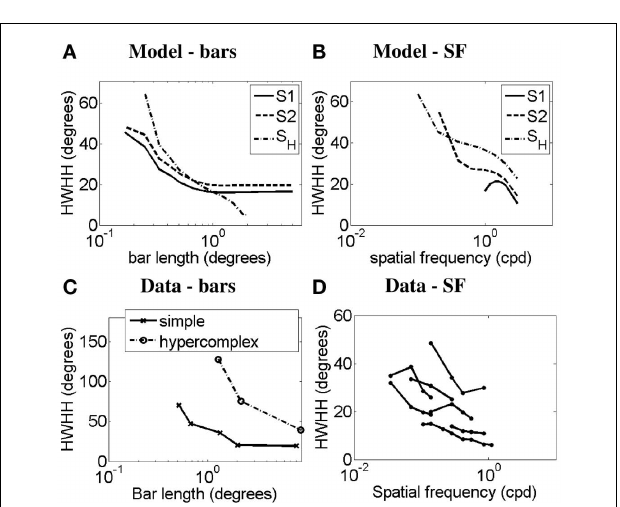
FIGURE 9 | Half-width-at-half-height (HWHH) versus bar length and HWHH versus spatial frequency. HWHH versus bar length curves produced by (A) the model and (C) real simple cells in response to bars (Data adapted from Henry et al., 1974 and Orban et al., 1979). In (A,C) the y -axis represents the HWHH in degrees, and the x -axis represents the bar length in degrees. HWHH versus SF curves produced by (B) the model in response to gratings and Gabor patches and (D) real simple cells in response to gratings (Data adapted fromVidyasagar and Siguenza, 1985). In (B,D) the y -axis represents the HWHH in degrees, and the x -axis represents the SF in cpd. Legend – S1: simple cell S1, S2: simple cell S2, S H : simple-like hypercomplex